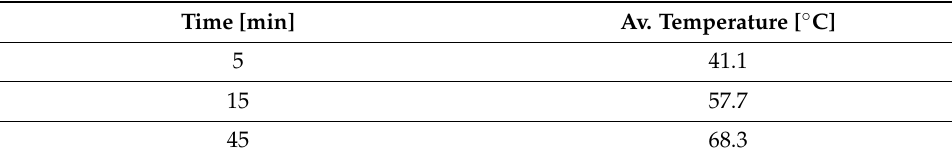
Table 3. Average sample temperatures for the selected experiment duration.